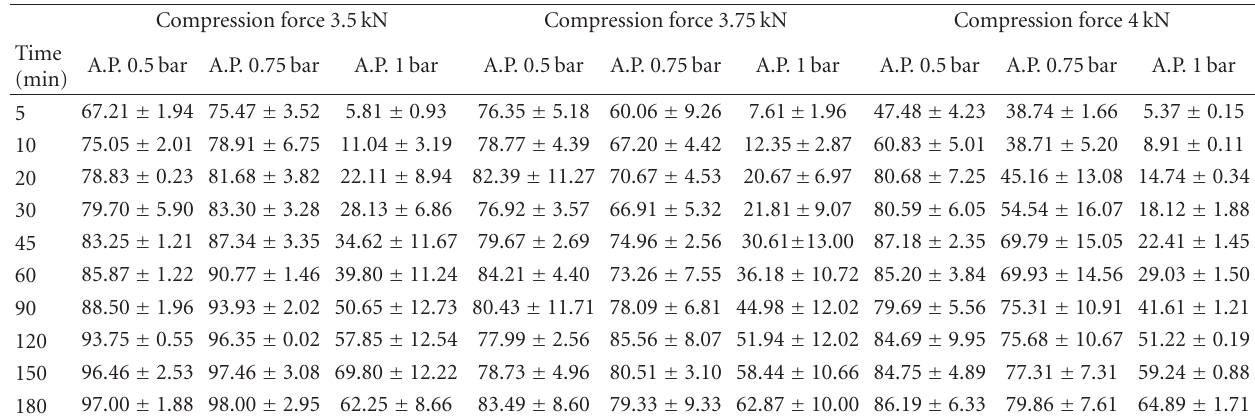
Table 8: The percentage of paracetamol released from tablets in di ff erent time interval during 3 hours.